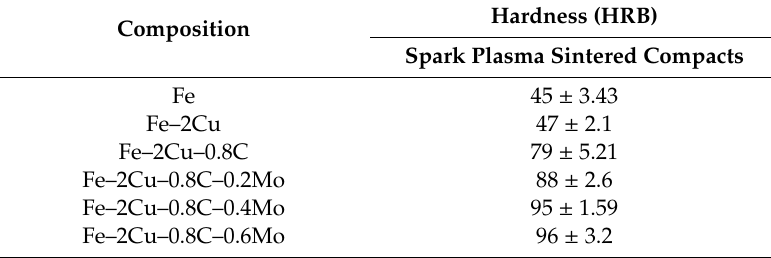
Table 4. Rockwell hardness values of Fe and its alloying additions consolidated in Spark plasma sintering